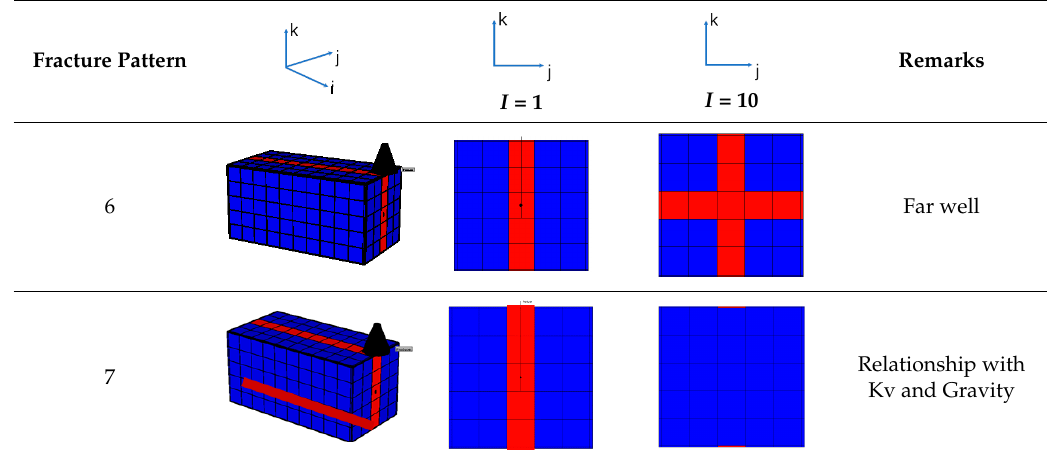
Table 6. Cont. Table 6. Settings of fracture contact relationships. Table 6. Settings of fracture contact relationships. Table 6. Settings of fracture contact relationships.